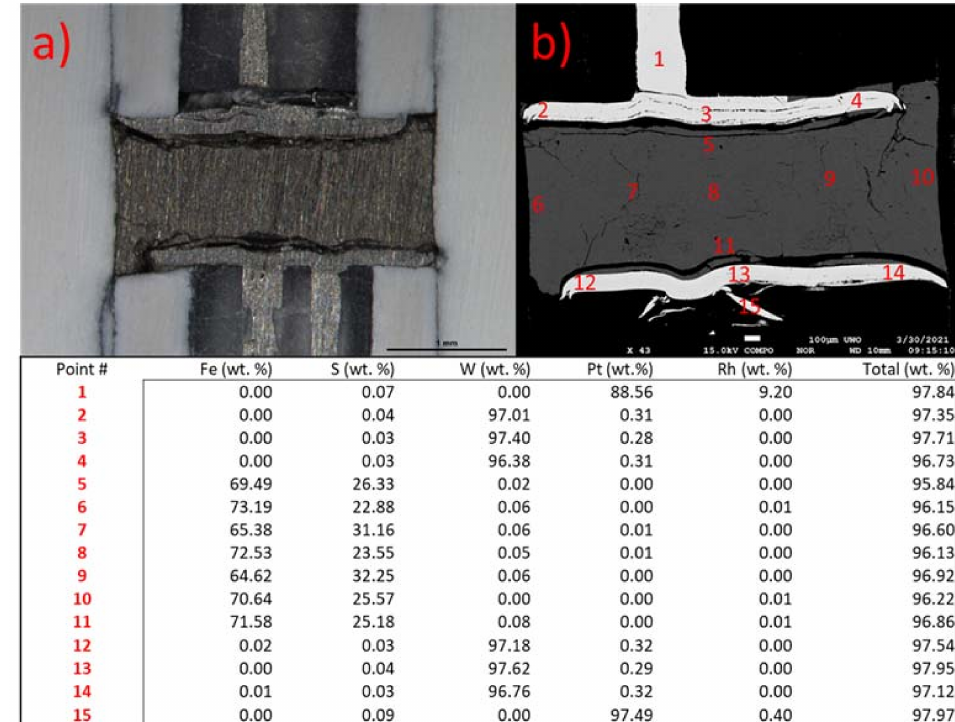
Figure 2. ( a ) Cross-sectional view of the post-experiment 4 GPa pressure cell; ( b ) backscattered electron image of the sample from ( a ) at a different depth due to additional grinding and polishing required for electron microprobe analysis. Results of the microprobe are